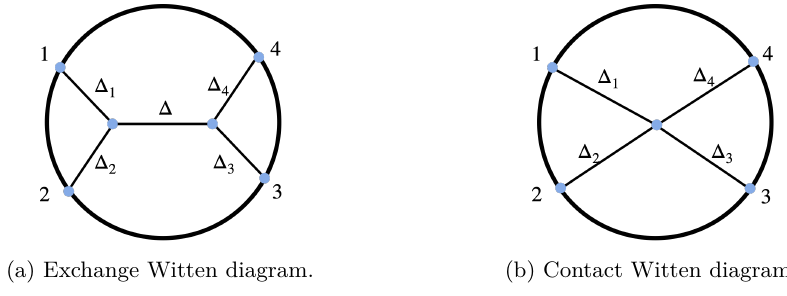
Figure 2 . The simplest four-point Witten diagrams at tree